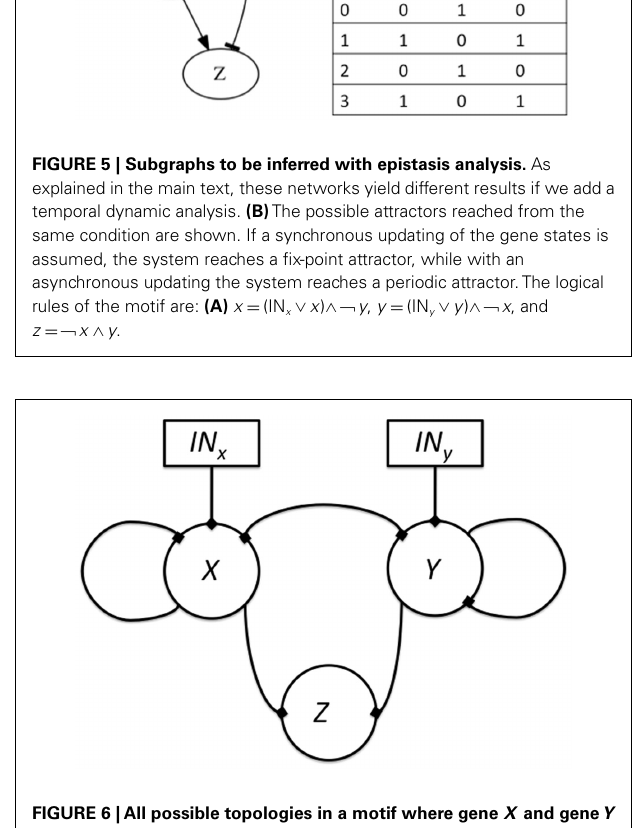
FIGURE 6 |All possible topologies in a motif where gene X and gene Y regulate the state of a gene Z . The edges represent possible regulatory interactions.These interactions can be positive, negative or null (i.e., inexistent).The inclusion of an input over genes X and Y is assumed because it is not clear which gene is upstream and which one is